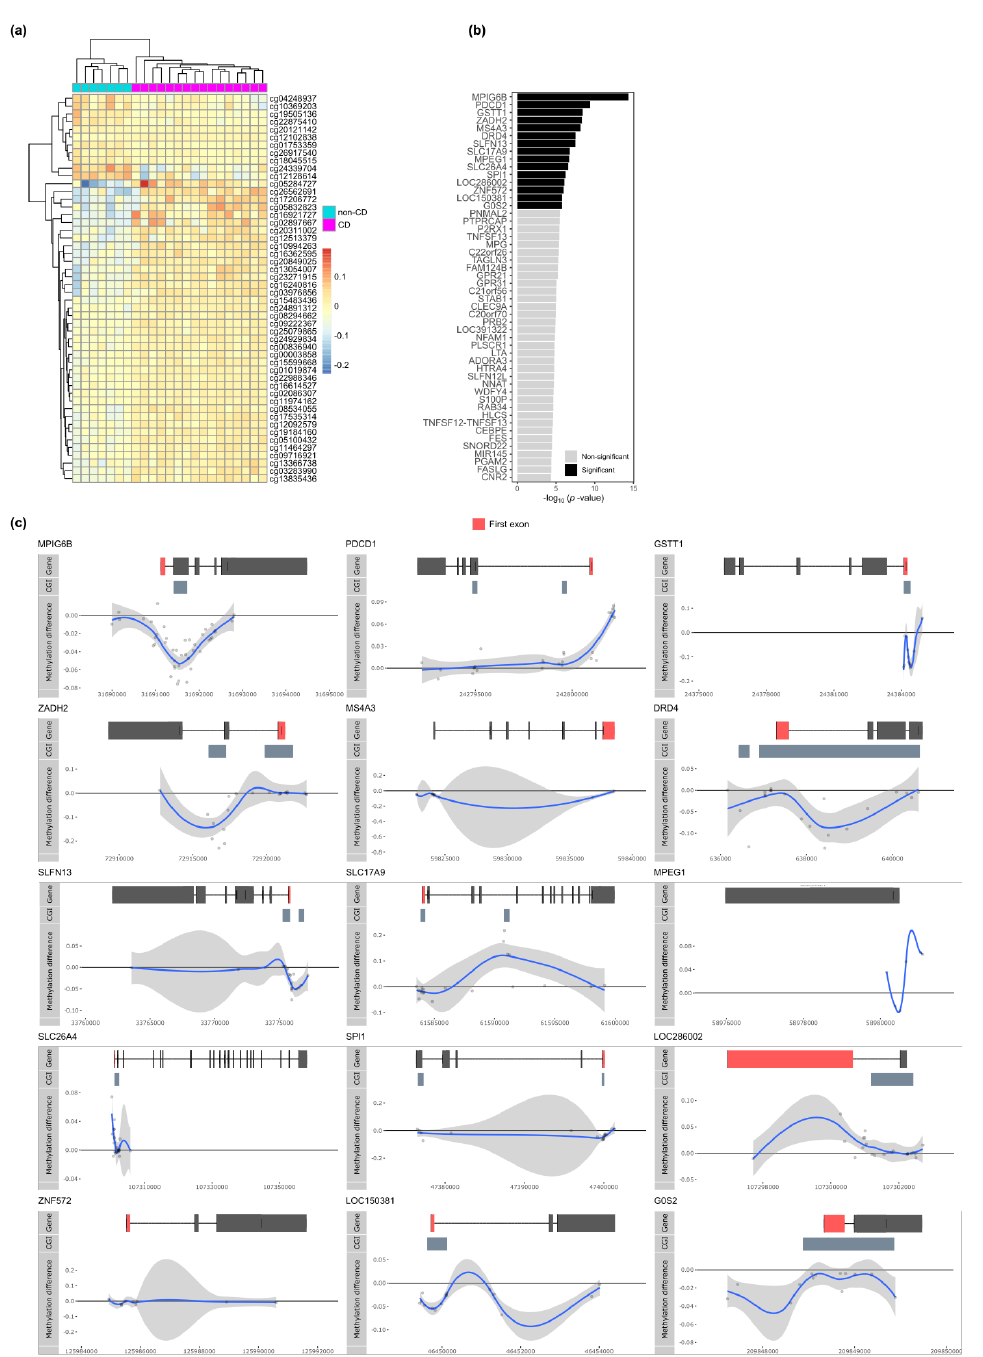
Figure 1. Comparing Crohn’s disease (CD) ( n = 7) with non-CD ( n = 16). ( a ) Heatmap organized by hierarchical clustering of the 50 most differentially methylated probes (DMPs) annotated with Illumina probe IDs. ( b ) Barplot depicting the –log 10 ( p -value) obtained from Brown’s method for the differentially methylated genes (DMGs). Significant DMGs are indicated in black, while non-significant genes are indicated in grey. ( c ) Visualization of the significant DMGs by plotting the difference in percentage methylation relative to the position on the chromosome and the gene (“Gene”) and CpG island (“CGI”) features as obtained from UCSC. Dots represent probes on the Illumina HumanMethylation 450k BeadChip array. The blue trend line represents the loess-smoothed average across all methylation probes for the indicated region with surrounding grey area representing the standard